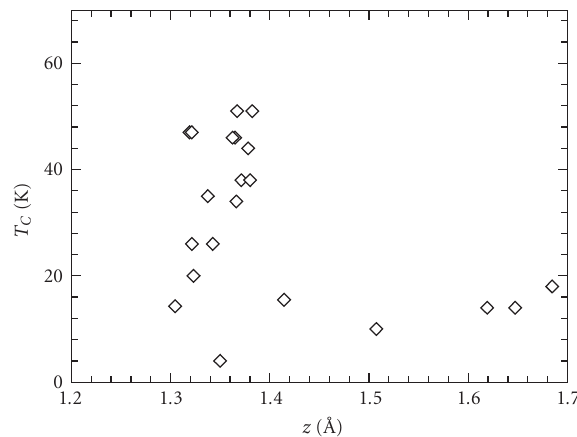
Figure 4: Superconducting critical temprture T C , as a function of the As-Fe layer separation, z